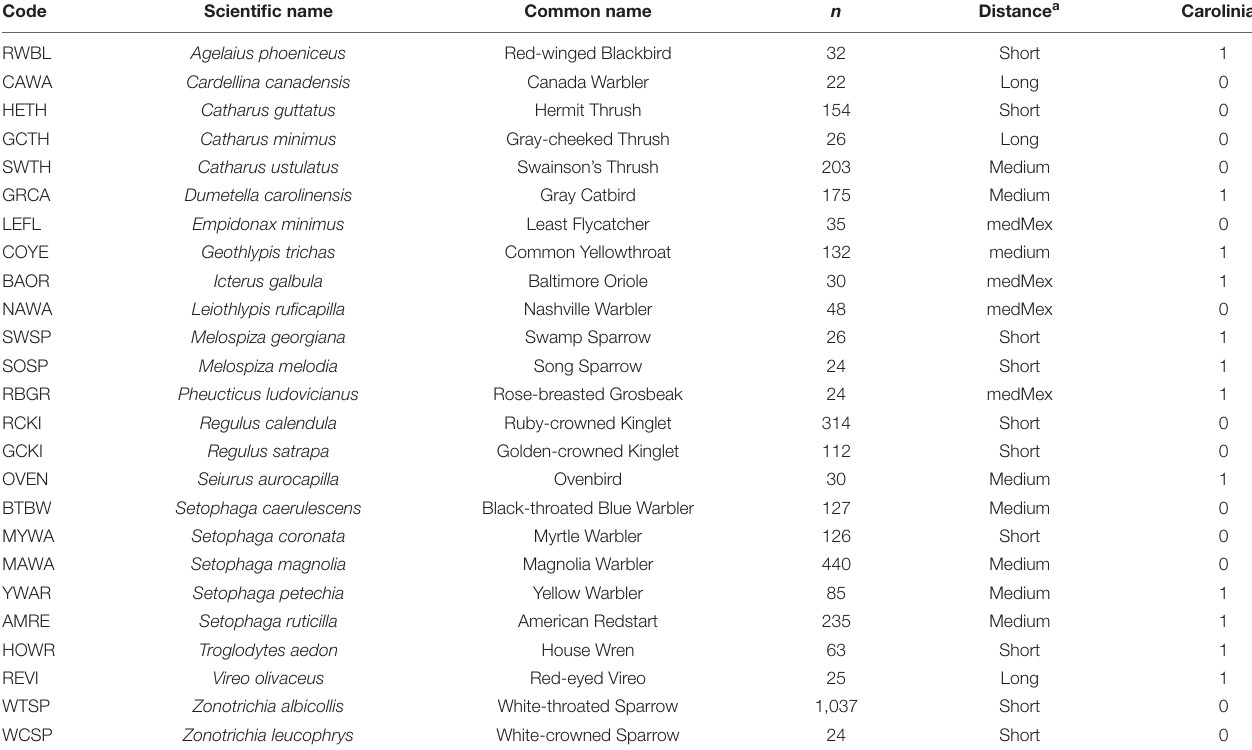
TABLE 1 | Songbird species used in the study of lean and fat mass scaling, showing the species code, scientific name, common name, single scan sample size, migration distance, and breeding location (Carolinian Zone or not).